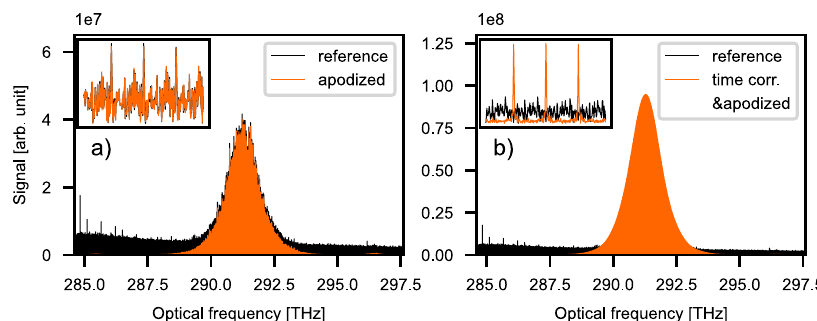
Fig. 5 Dual-comb spectra before and after applying the correction. a Apodized (orange) and not corrected (black) spectra transformed from a 312 ms time trace. Forty interferograms contributed in both cases. It is clearly seen that Δ f jitter-corrected spectrum experiences a signi fi cant decrease in noise. rep The inset shows the frequency comb lines of both spectra. b Δ f rep jitter-corrected and apodized spectrum and